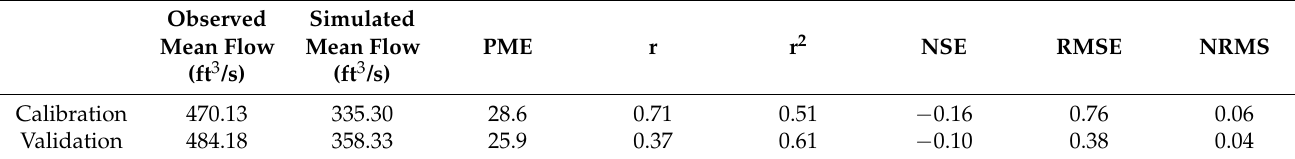
Figure 2. Flow calibration and validation. Table 6. Flow calibration and validation statistical results